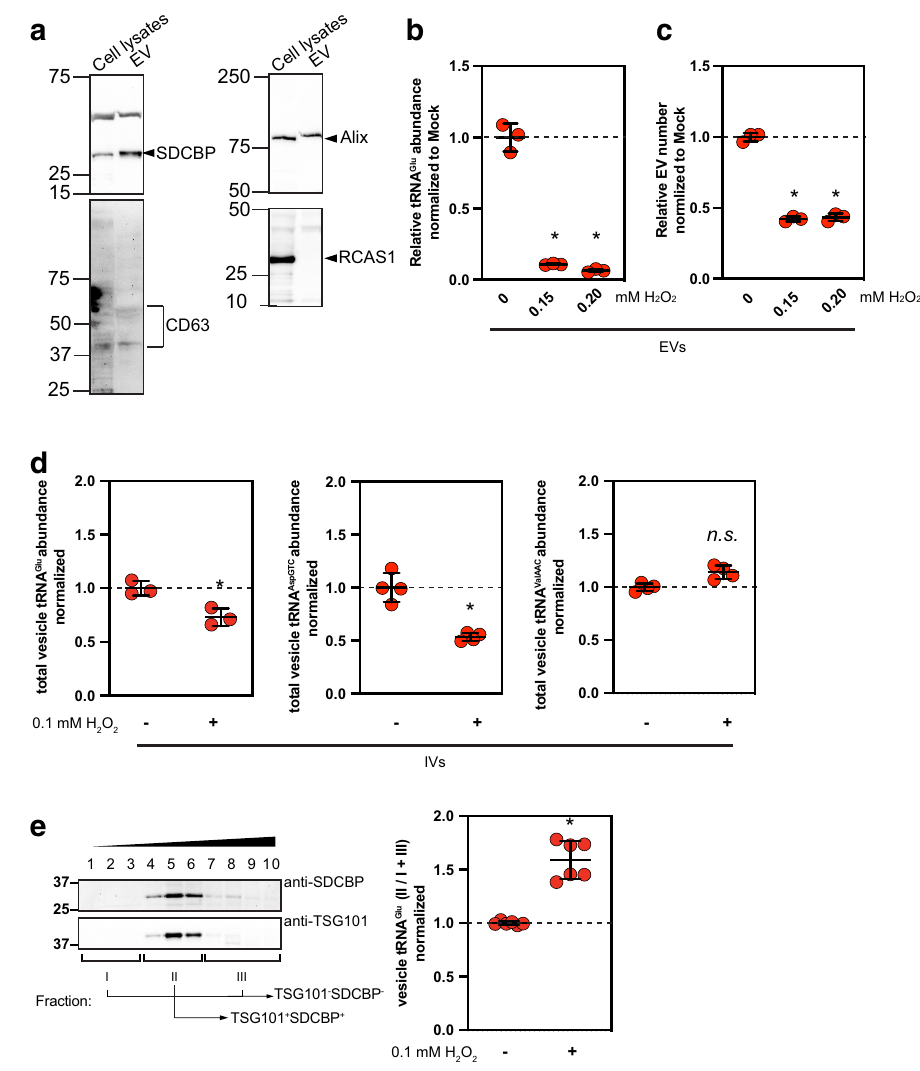
Figure 3. Extracellular and intracellular distributions of vesicle-loaded tRNA Glu under oxidative stress. BUMPT cells were treated with the indicated concentrations of H 2 O 2 for 1 h and thereafter conditioned for 23 h with serum-free, H 2 O 2 -free growth media. Note that cell viability was not significantly affected in this condition. ( a ) Immunoblotting analysis showing the indicated proteins in extracellular vesicle (EV) fraction, validating the extracellular vesicle isolation protocol used in this study. RCAS1 was used as negative control. ( b ) Relative tRNA Glu abundance in extracellular vesicles from cells under oxidative stress. Benzonase was used to degrade RNAs associated nonspecifically with the surface of extracellular vesicles. * p < 0.05. ( c ) Total number of extracellular vesicles (EV) from cells under oxidative stress. Note that transient oxidative stress decreases release of extracellular vesicles. * p < 0.05. ( d ) Relative abundances of intracellular vesicle tRNA Glu , tRNA AspGTC , and tRNA ValAAC under oxidative stress. Benzonase was used to degrade cytoplasmic RNAs associated nonspecifically with the surface of intracellular vesicles. Note that transient oxidative stress resulted in reduced loading of tRNA Glu and tRNA AspGTC in intracellular vesicles. * p < 0.05. ( e ) Transport of tRNA Glu to SDCBP or TSG101- positive endosomes under oxidative stress. A 0.4–1.8 M continuous sucrose gradient was used to separate intracellular vesicles enriched with exosome cargo proteins, SDCBP and TSG 101. Post-nuclear supernatants were pelleted at 100 K × g, and the resuspended pellets were top-loaded on the gradient to separate intracellular vesicles, based on their size and density. Note that benzonase was used to degrade cytoplasmic RNAs. Total RNA measurement, RT-qPCR, and western analysis were performed as described in “Methods” section. * p <